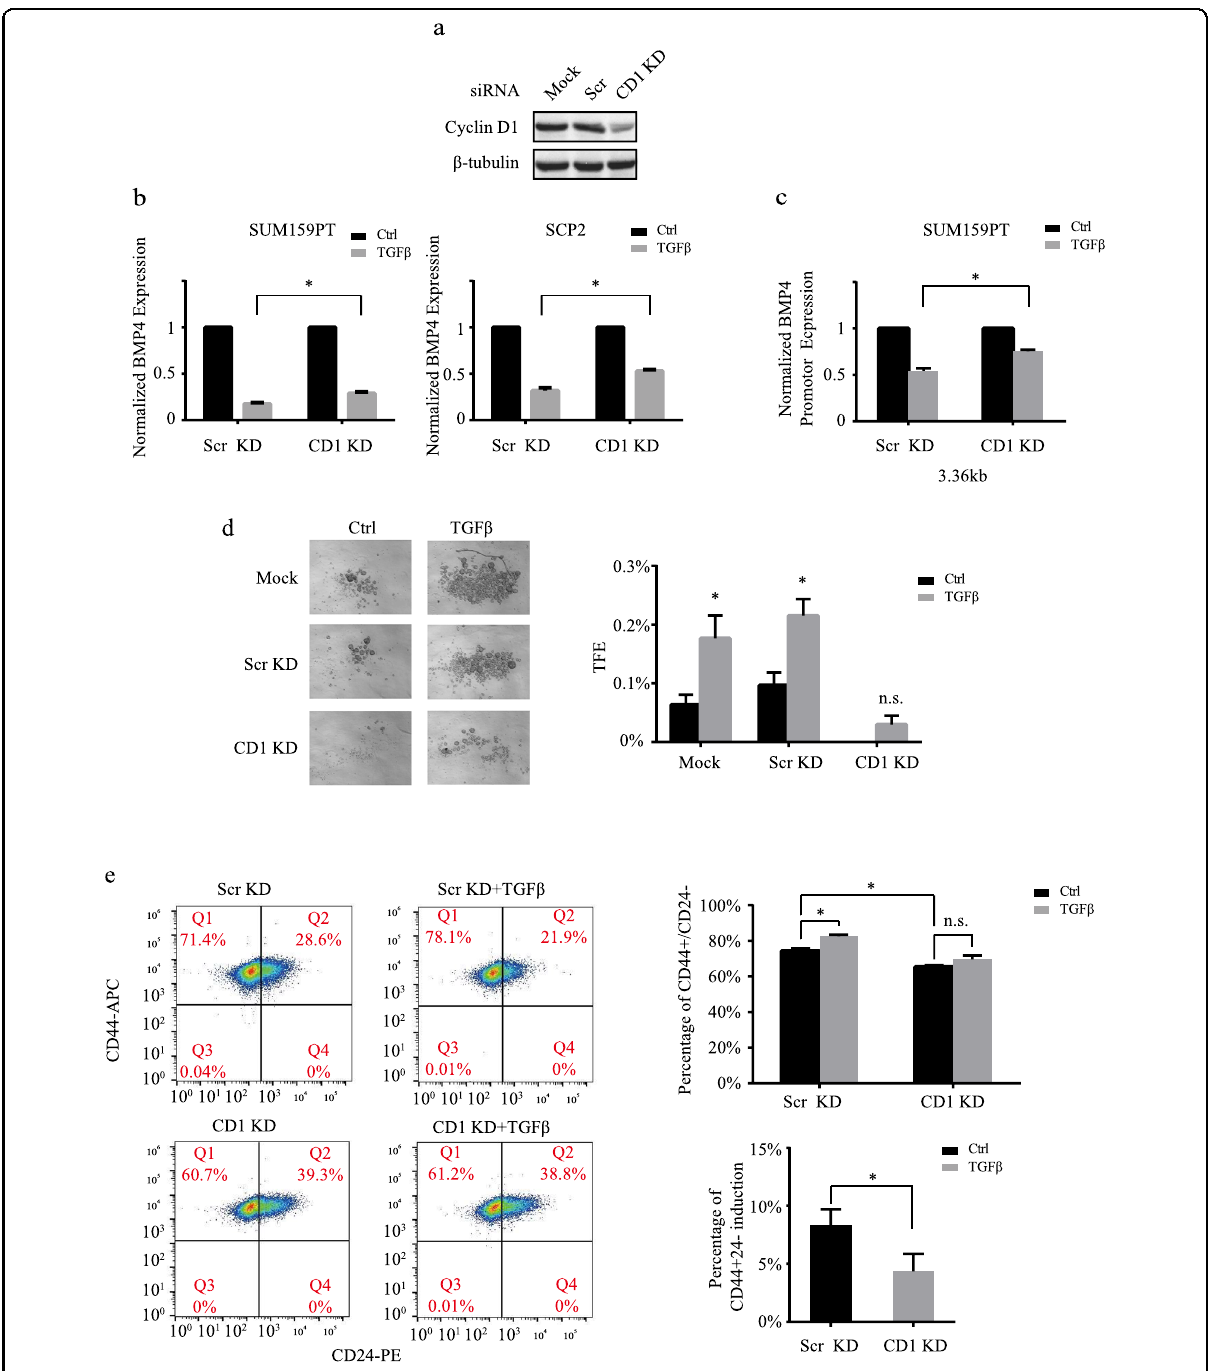
Fig. 3 Cyclin D1 is required for TGF β inhibition of BMP4. a Immunoblot analysis to assess cyclin D1 knockdown ef fi ciency. b Cyclin D1 knockdown effects on TGF β -mediated BMP4 expression. c Cyclin D1 knockdown effects on TGF β -mediated BMP4 gene promoter inhibition. d , e Cyclin D1 knockdown effects on TGF β -mediated tumorsphere formation ( d ) and TGF β -induced CD44 high /CD24 − /low cell numbers ( e ). Data represent means ± SEM of triplicate experiments. * P ≤ 0.05; n.s. not signi fi